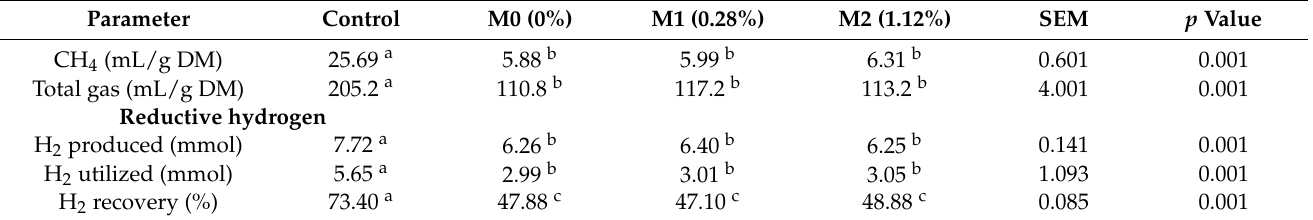
Table 3. In vitro rumen fermentation parameters.